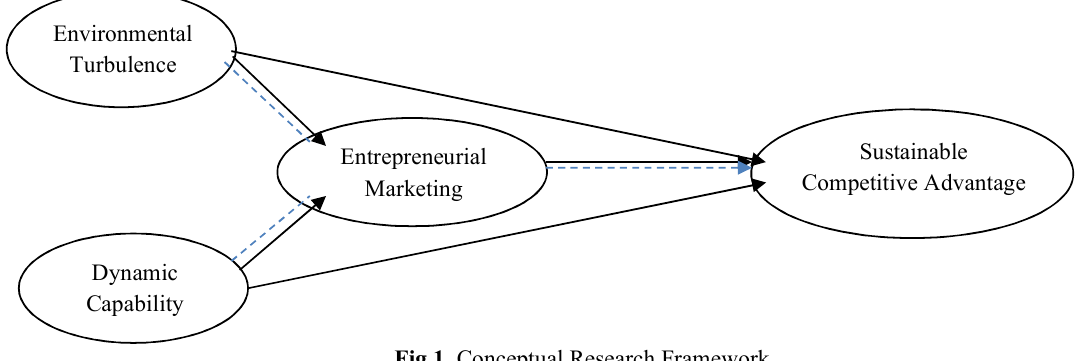
Fig.1. Conceptual Research